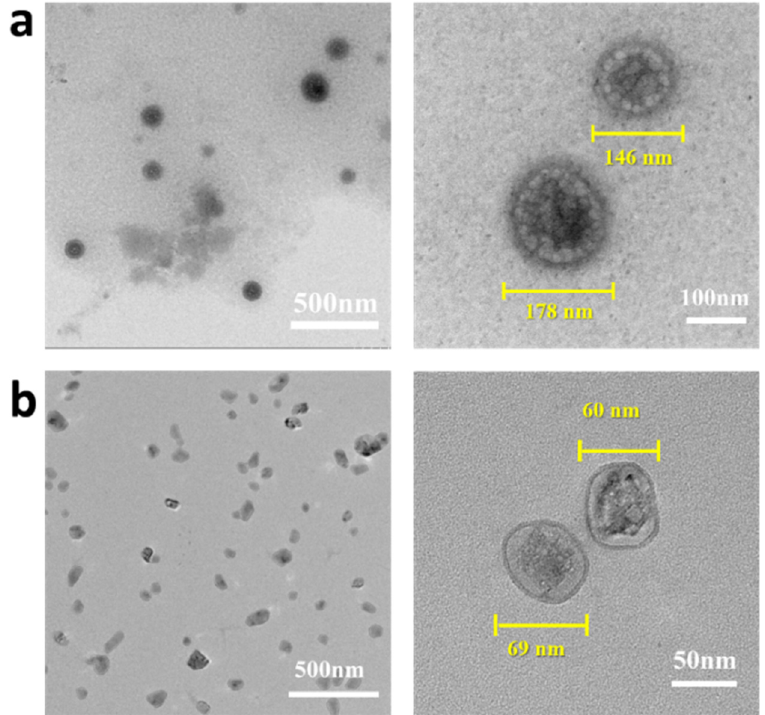
Figure 4. TEM images of the DOX-loaded Hep/PQCS-PVA NPs, the samples came from ( a ) deionized water and ( b ) DMEM. The images on the right are taken in high resolution